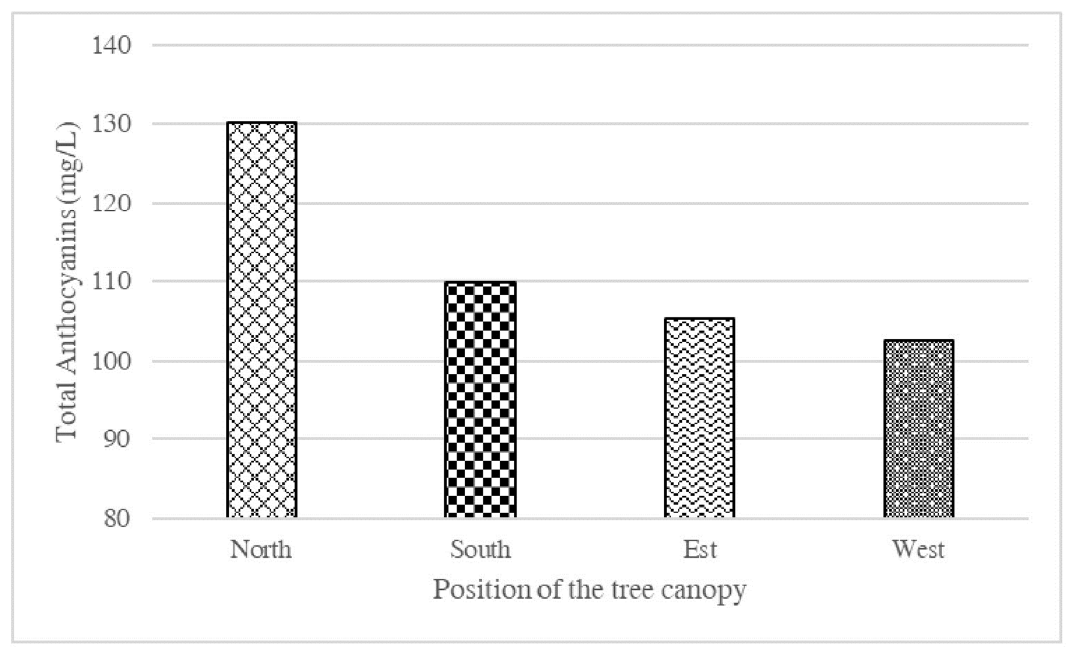
Figure 6. Anthocyanin content in ‘Moro’ fruits collected from different positions of the tree